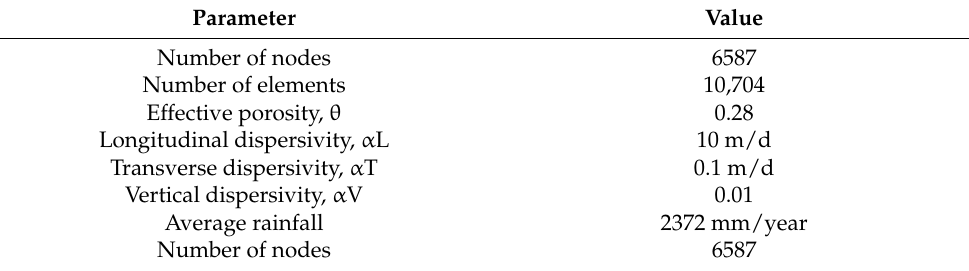
Figure 2. Three-dimensional representation of the model’s boundary conditions. Table 1. The study aquifer’s physical and hydrogeological properties.